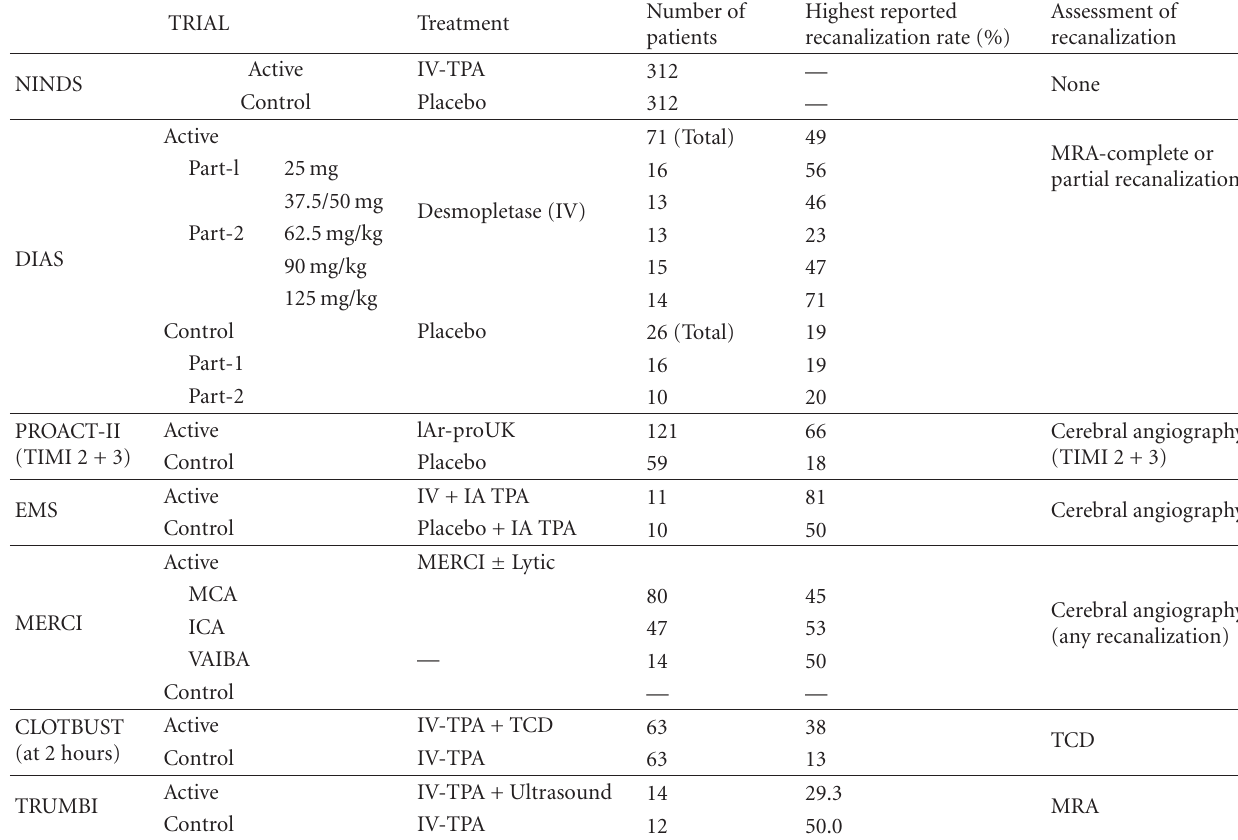
Number of Highest reported Assessment of patients recanalization rate (%)